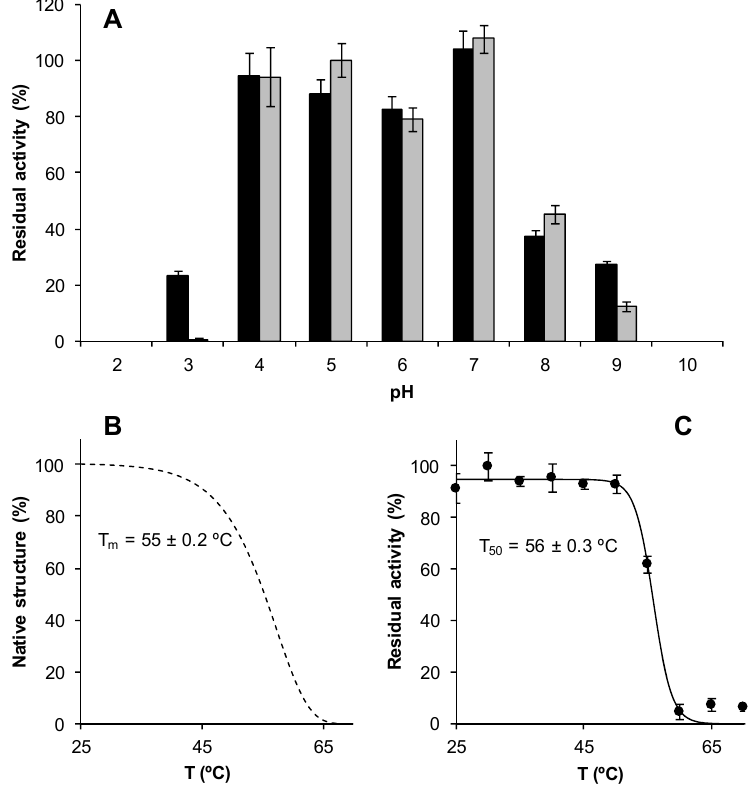
Figure 4. Effect of pH and temperature on ApeLiP stability. ( A ) pH stability as residual activities after 4 (black) and 24 (gray) hours incubation in 100 mM Britton–Robinson buffer (pH 2–10) at 25 °C. ( B ) Effect of temperature on protein denaturation measured by CD at 222 nm. ( C ) Thermal effect on ApeLiP activity after incubation in 10 mM sodium acetate, pH 5.5, for 10 min. T m and T 50 values are provided. Residual activities were measured with 1.25 mM ABTS and 0.1 mM H 2 O 2 in 100 mM sodium tartrate, pH 3. Means and standard deviations are shown.